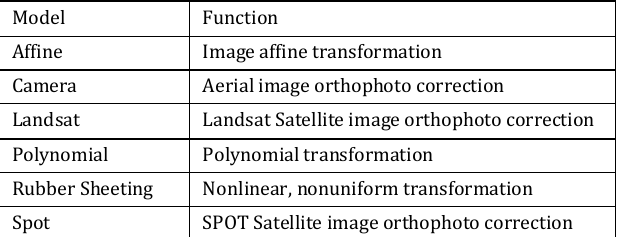
Table 2: Geometric correction and model functions